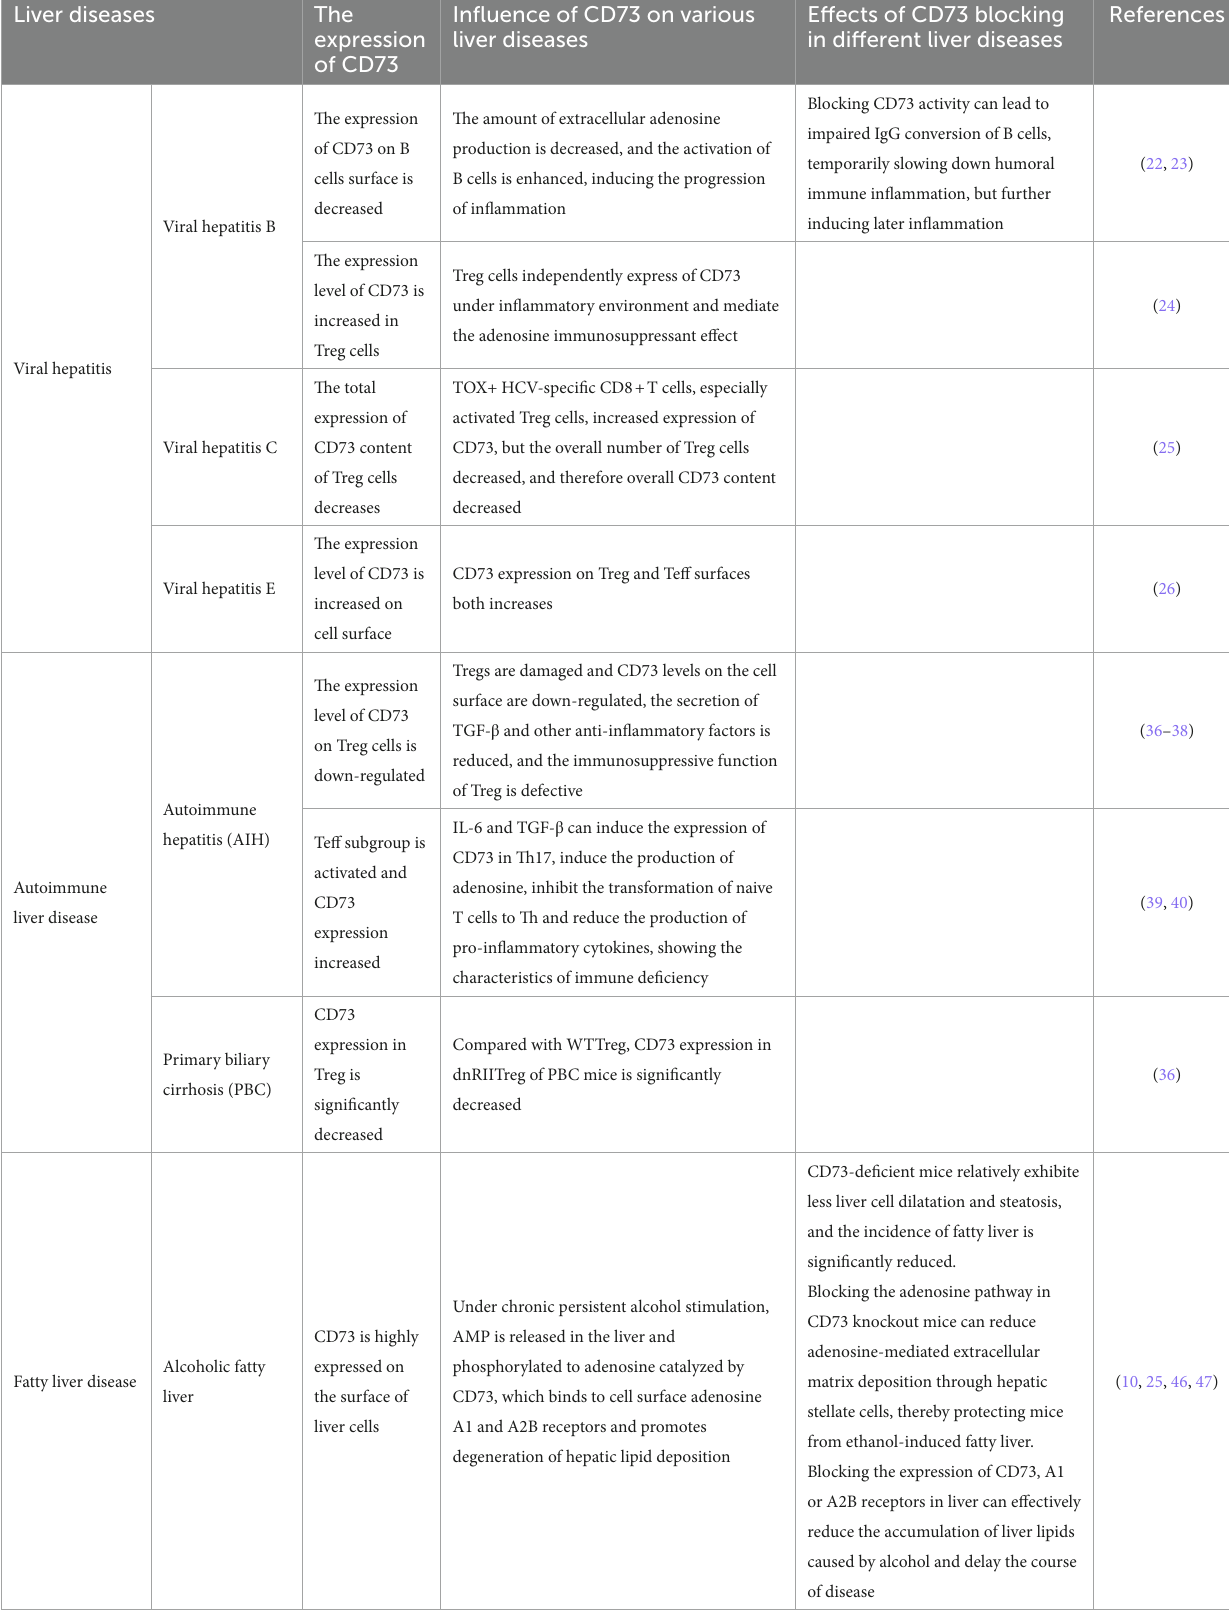
TABLE 3 List of different effects of CD73 in liver diseases. Liver